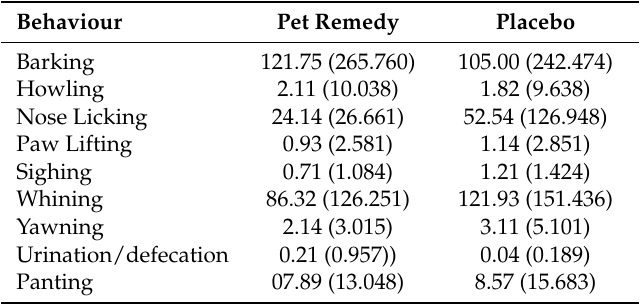
Table 3. The mean ( ± S.D.) frequency each behaviour was displayed by the dogs in the Pet Remedy and placebo